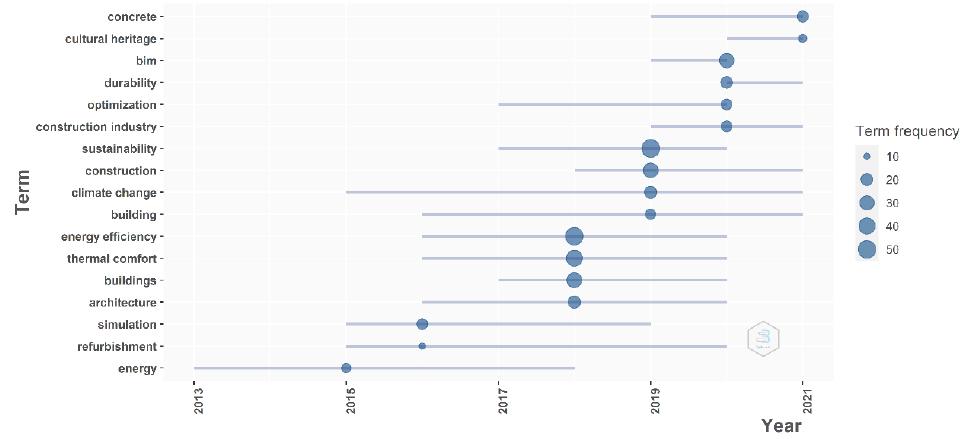
Figure 6. Trending topics.